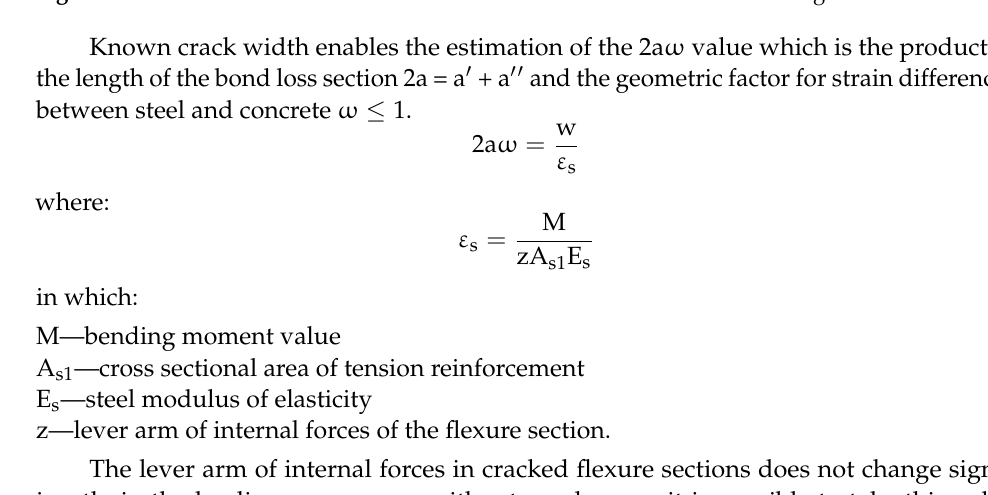
Figure 31. Increase in the mean crack width on individual beams under